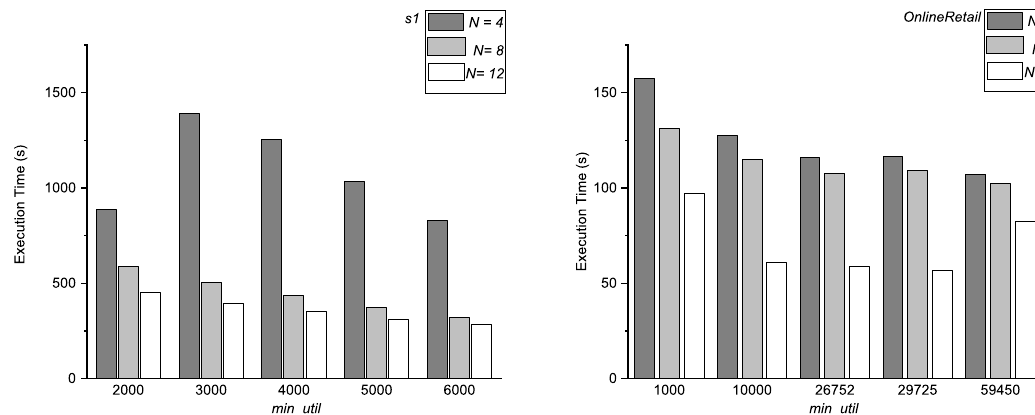
Figure 9: Comparison of execution time by varying number of cluster nodes.